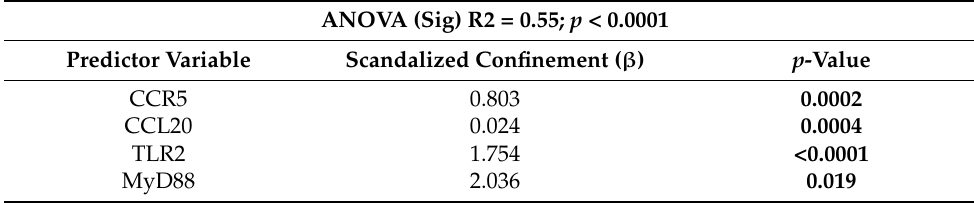
Table 4. Multi Linear Regression analysis, with Dectin-1 as a dependent